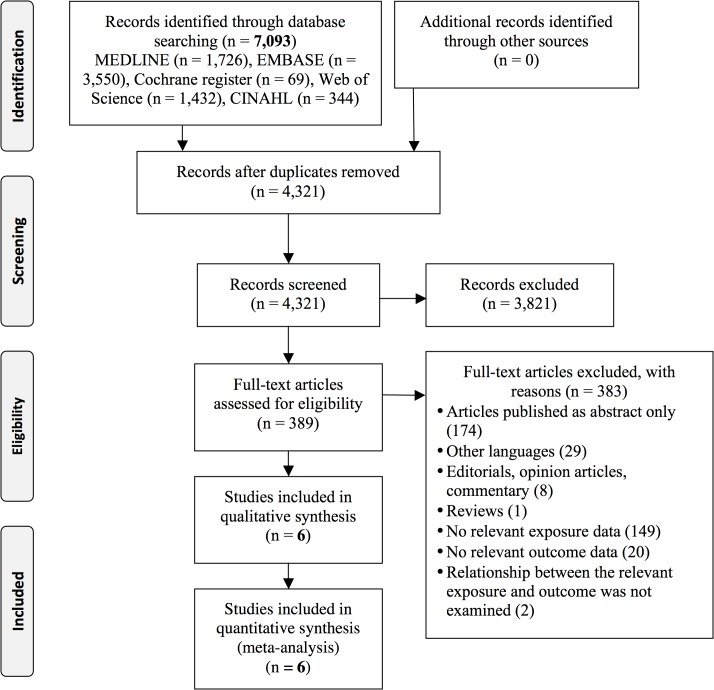
Flow diagram of study selection process.